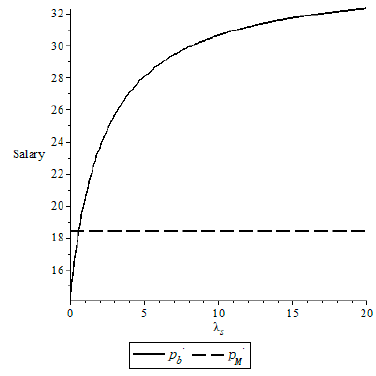
Figure 2. Change of the salary with λ s.